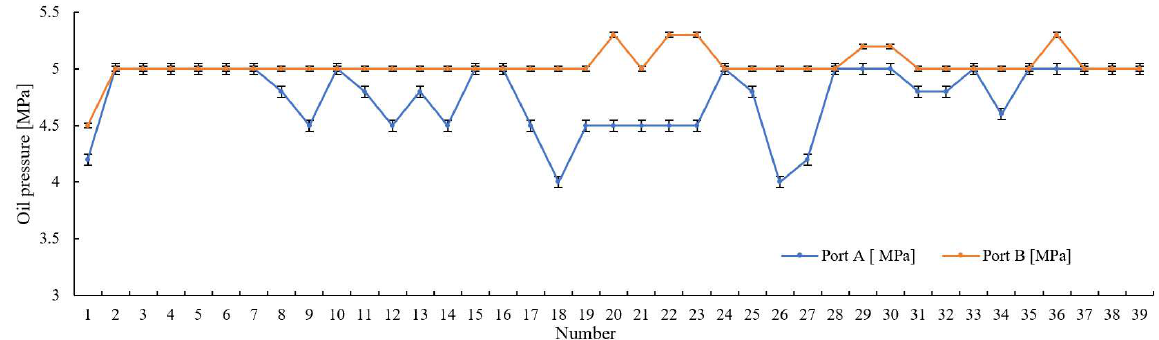
Figure 9. Power oil pressure of the grease suction and drainer devices after 12,000 fatigue tests. In order to verify the reliability of the measured power oil pressure of the grease suction and drainer devices, descriptive statistical analysis was performed based on the test data of Figure 9. The results of the calculations are presented in Table 2. Table 2. Results of descriptive statistics of power oil pressure after 12,000 fatigue tests. Variable Name